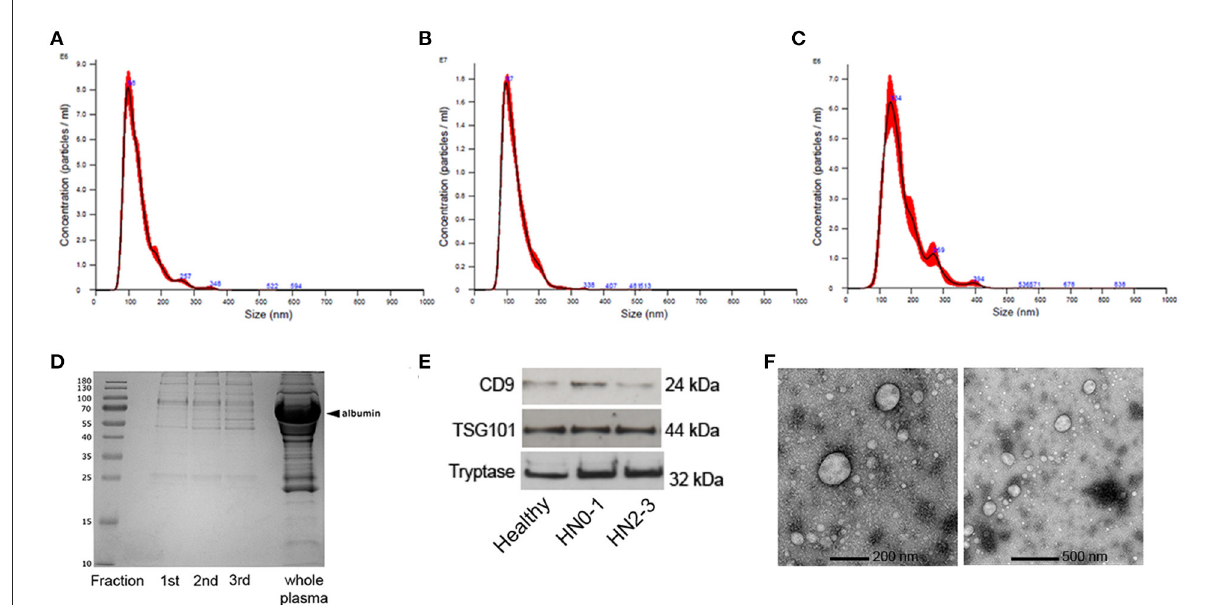
FIGURE1 Characterization of extracellular vesicles (EVs) isolated by Size Exclusion Chromatography (SEC) from plasma of dogs. Nanoparticle tracking analysis of EVs from (A) non-metastatic/pre-metastatic (HN0-1) MCT. (B) Early-metastatic/overt-metastatic (HN2-3) MCT and (C) healthy sample. (D) Blue Coomassie staining of the three SEC fractions and the whole plasma. (E) sEV were loaded onto separate lanes, subjected to SDS PAGE, and transferred to nitrocellulose membranes; the immunoreactivity was detected with mouse anti-human CD9, rabbit anti-human